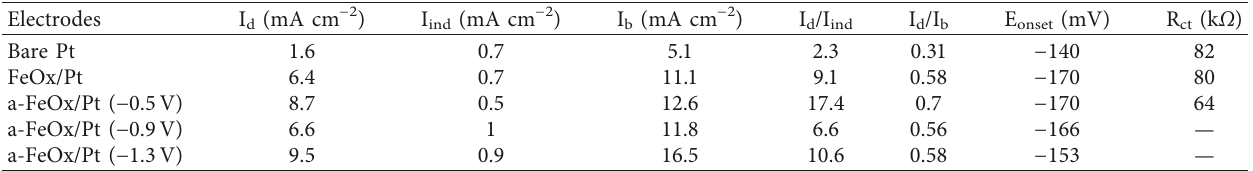
Figure 5: CVs in 0.3M FA (pH � 3.5) for the bare Pt (a), Au (b), and GC (c) catalysts before and after the modification with nano-FeOx and before and after activation at − 0.5, − 0.9, and − 1.3V. Table 2: Electrochemical measurements obtained for